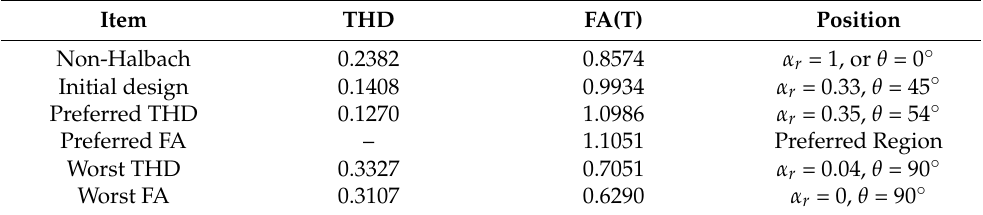
Figure 11. The predicted contours of THD (black numbers) and FA (red numbers) of ( a ) three-segment and ( b ) four-segment Halbach magnet array. α r represents the x-direction length ratio of the z-direction magnetized PM to τ . θ represents the angle of the angular magnetic PM. Table 2. Preferred and worst results of the three-segment Halbach magnet array.